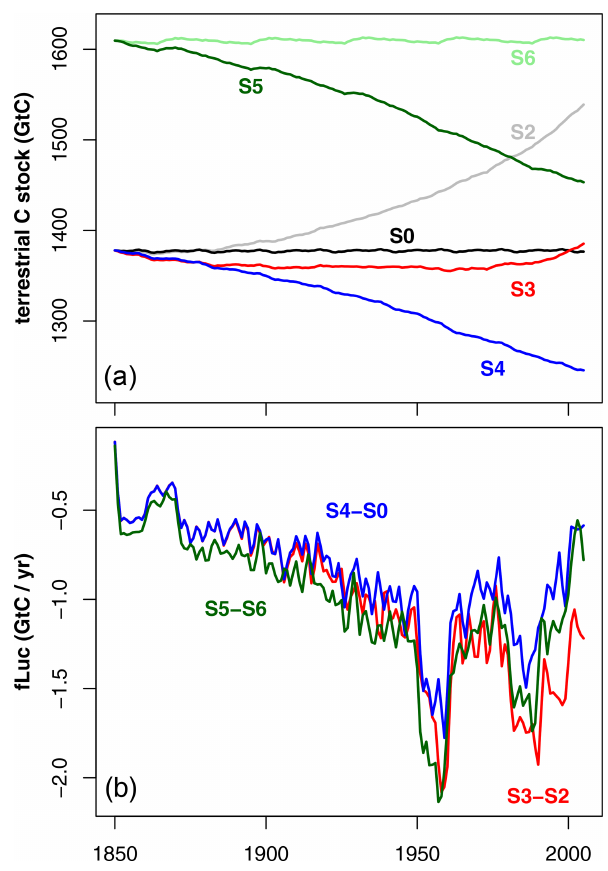
Figure 3. Terrestrial cumulative C stocks (a) and corresponding F LUC (b) as simulated by the JSBACH dynamic vegetation model for the different simulations discussed. Shown is F LUC derived as S5 minus S6, S3 minus S2, and S4 minus S0 (see